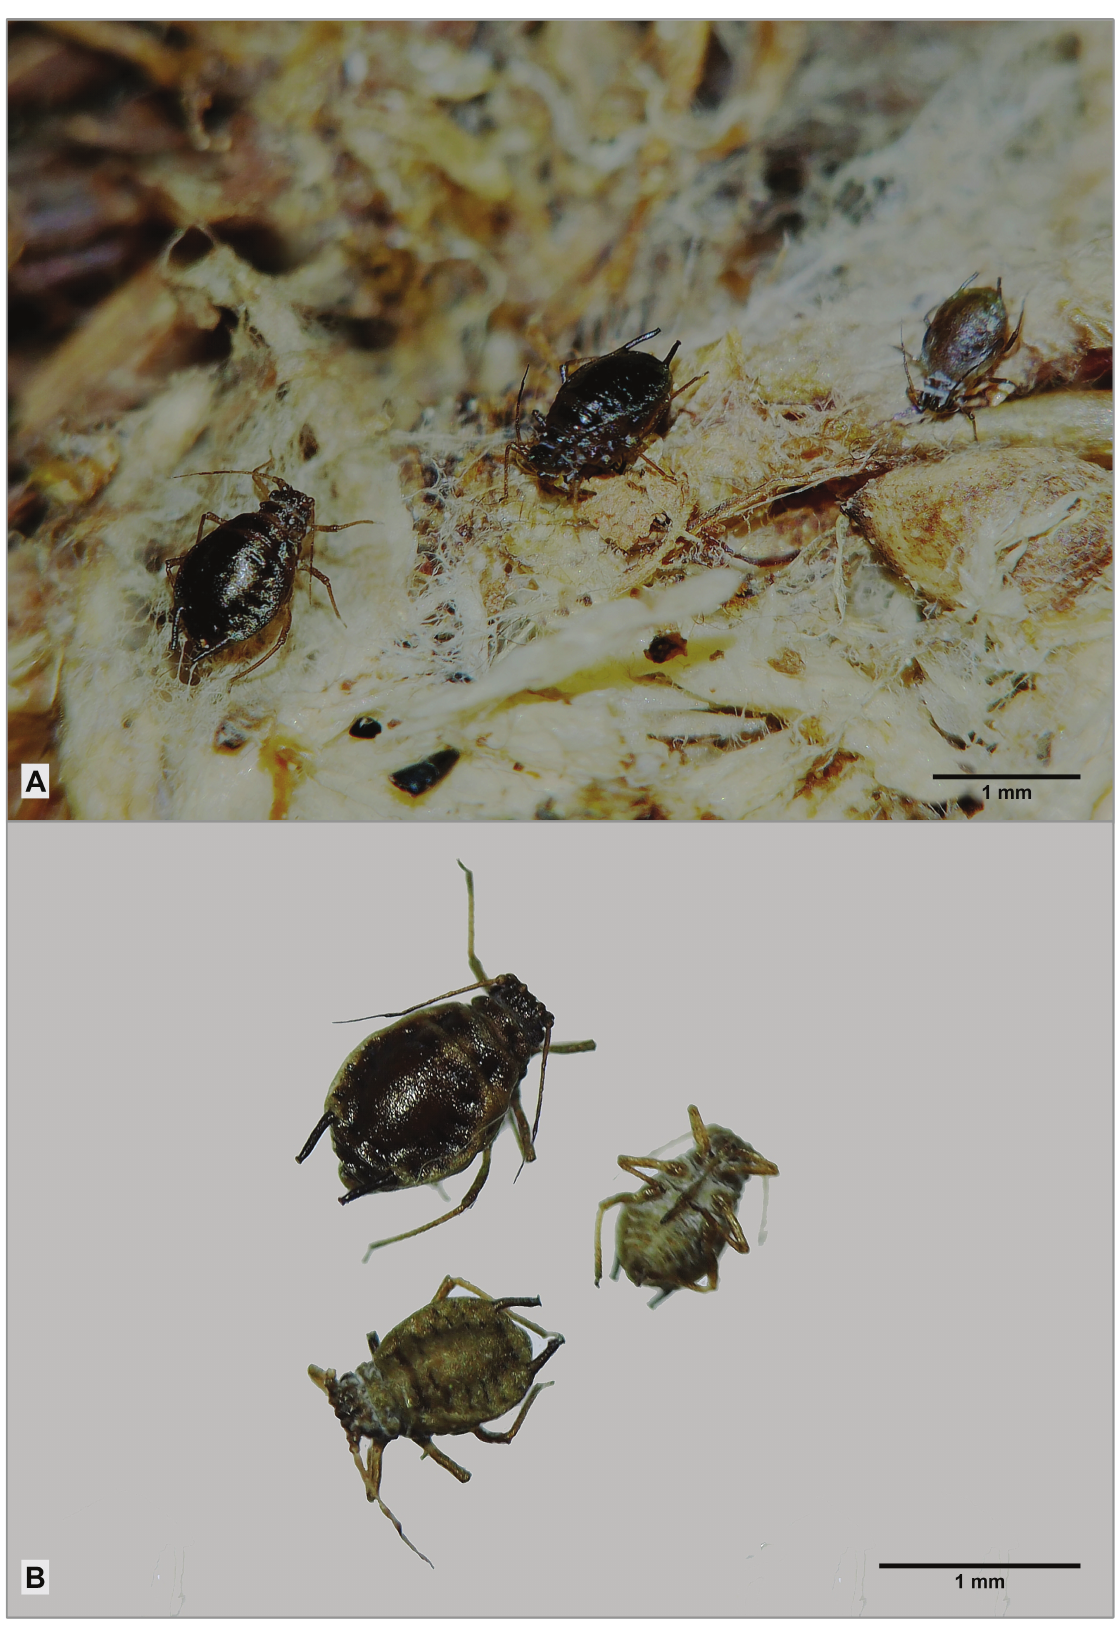
Fig. 8. Myzodium modestum (hottes, 1926). A–B . Apt. and juv. from Polytrichum commune